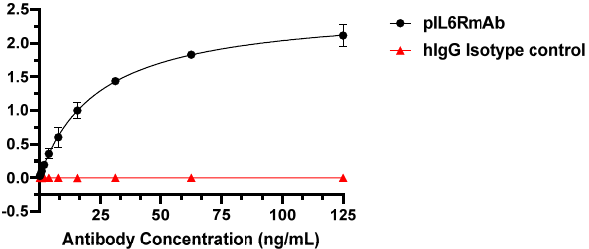
Figure 2. Purification of pIL6RmAb from N. benthamiana plants. Protein A affinity column-purified pIL6RmAb from leaves was analyzed on a 4–20% gradient SDS-PAGE gel under reducing (Lane 1) or non-reducing (Lane 3) conditions and visualized with Coomassie staining analysis. Lanes 1 and 3, Protein A-purified pIL6RmAb (2.5 µg); Lanes 2 and 4: human IgG as an isotype reference standard